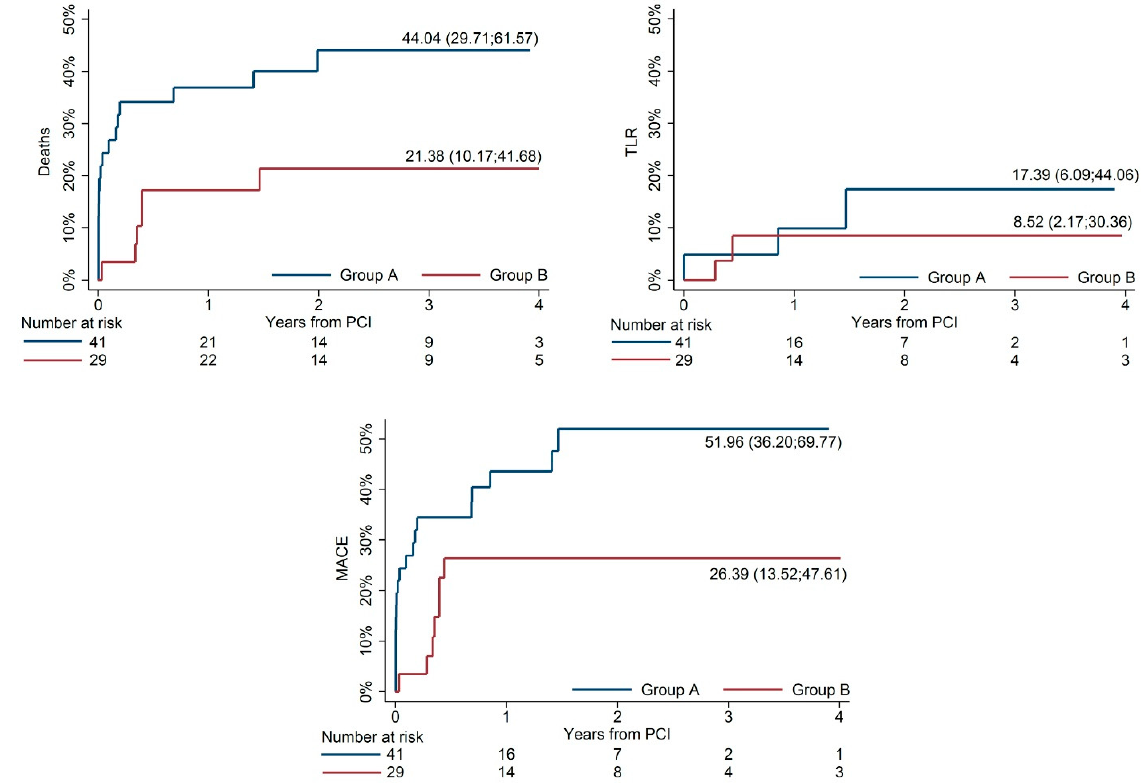
Figure 1. Unadjusted comparisons of mortality, TLR and MACE at 4 years according to the stent strategy in patients with unprotected left main coronary artery disease and acute coronary syndrome (Group A—one-stent strategy; Group B—two-stent strategy). Curves represent Kaplan–Meier failure function. TLR—target lesion revascularization; MACE—major adverse cardiac event. Predictors of late mortality and coronary reintervention are summarized in Table 6.